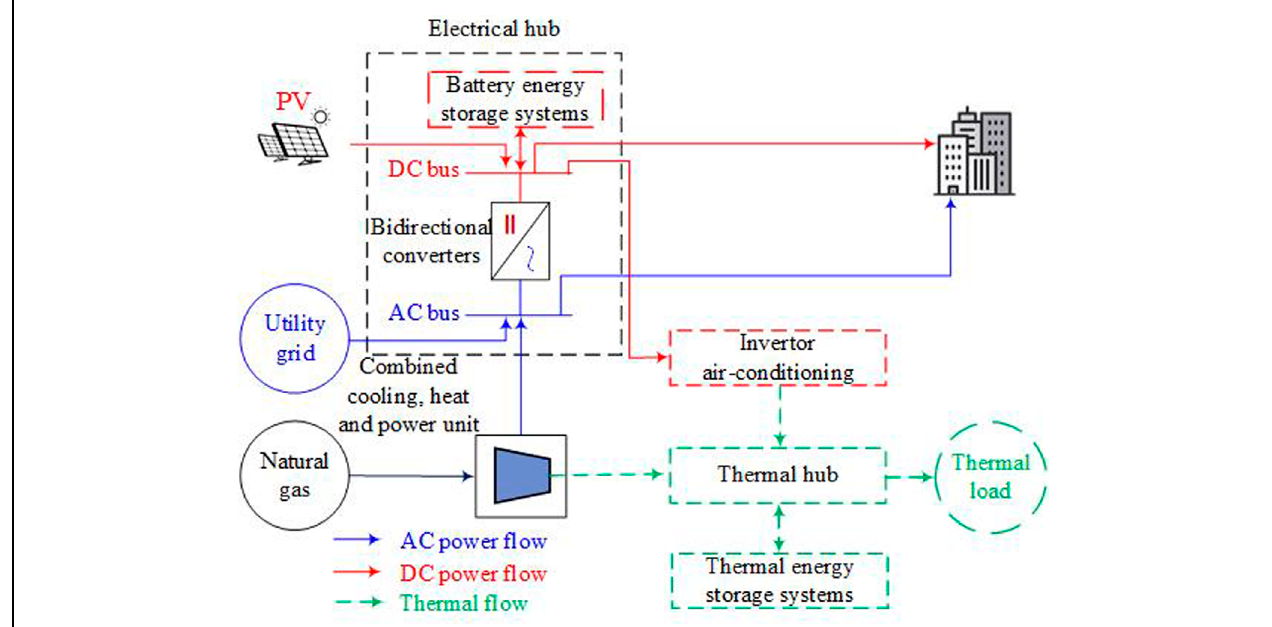
FIGURE 2 | Illustrative figure for the energy